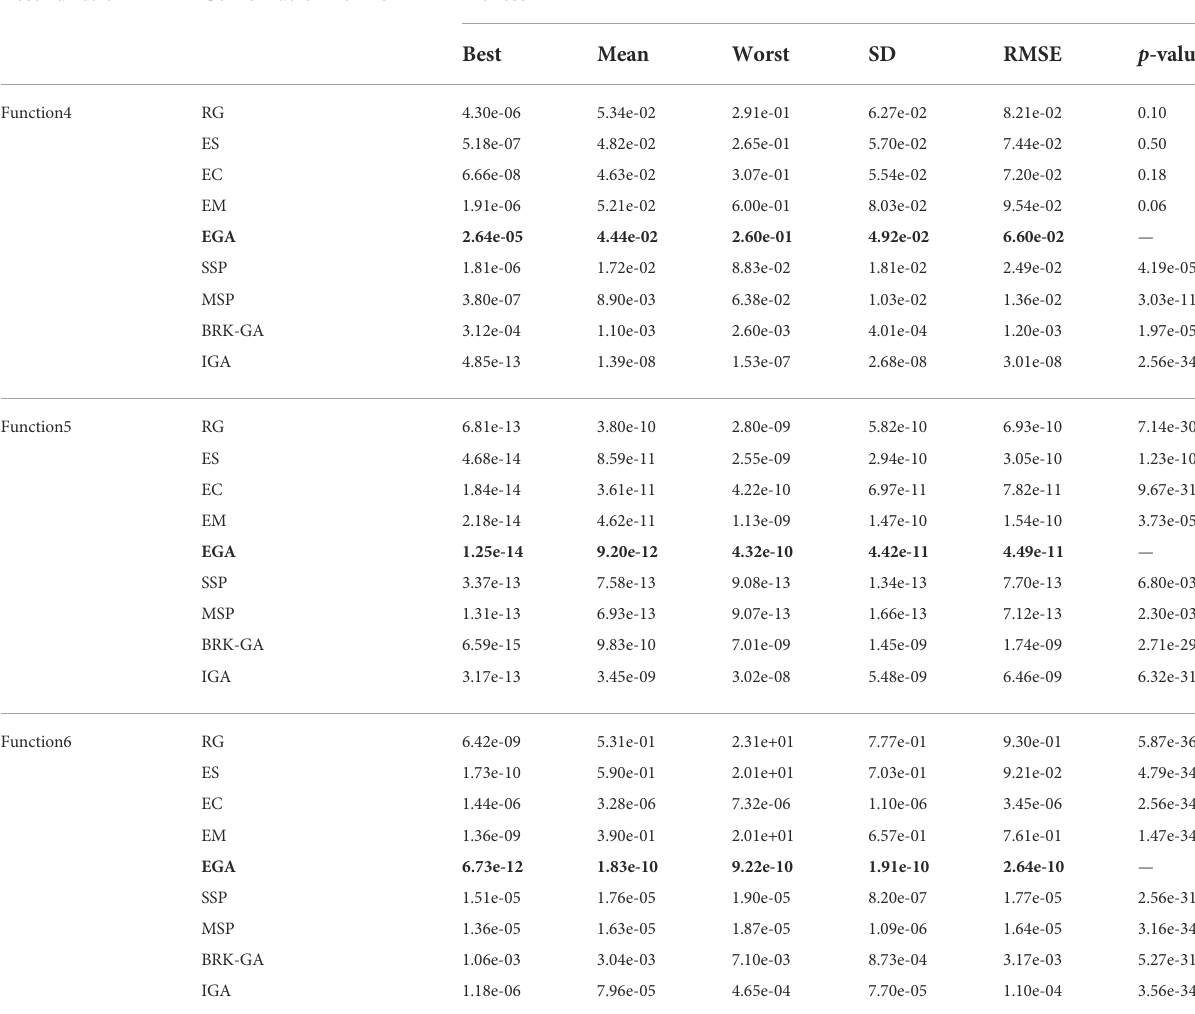
TABLE 4 Results of global indices for each evolutionary process of design experiments (2). Test